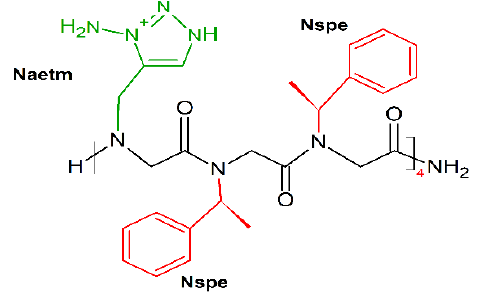
Figure 16. Chemical structure of H-(Naetm-Nspe-Nspe) 4 -NH 2 peptoid. In green: positively charged side chain; in red: hydrophobic side chain.